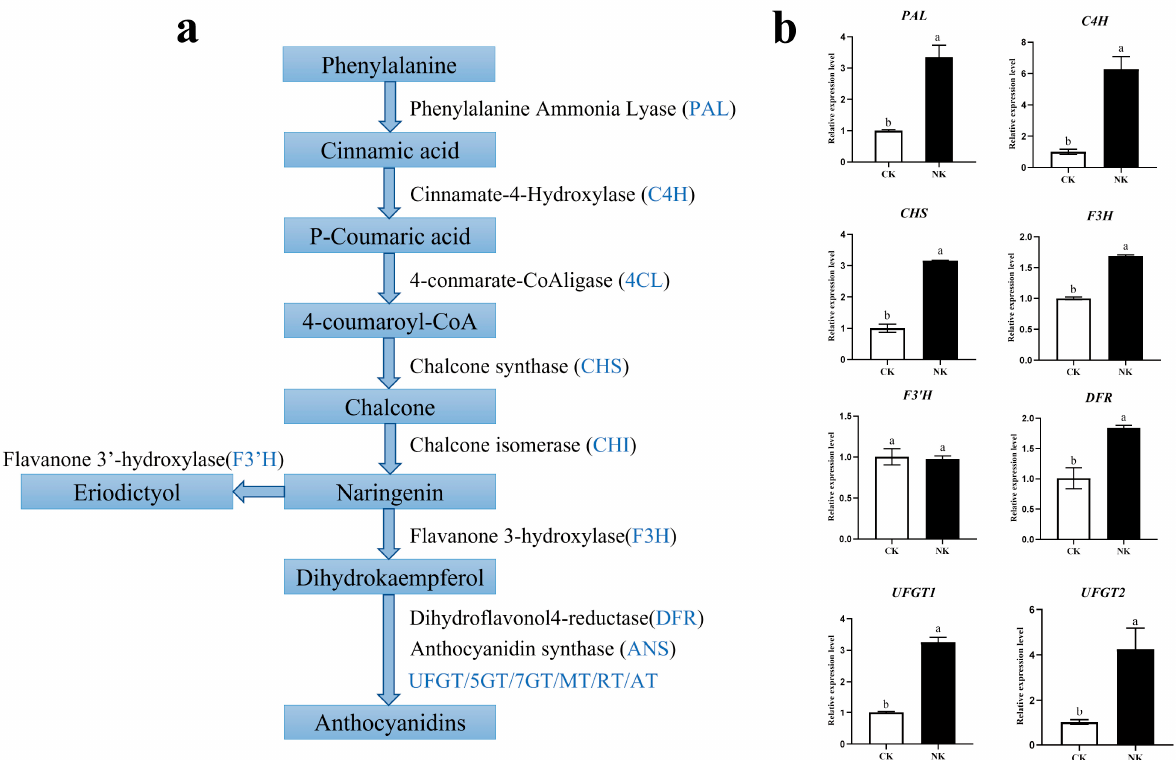
Figure 8. The expression levels of the gene involved in the flavonoid metabolism pathway. ( a ) Schematic diagram of the flavonoid synthesis pathway. ( b ) qRT-PCR analyzed the relative expression of flavonoid pathway structural genes. Different letters indicate a significant difference in the relative expression of the flavonoid pathway structural genes of water dropwort between different treatments, at the 5% level. Error bars show the standard deviation (SD) of three biological repli- cates.